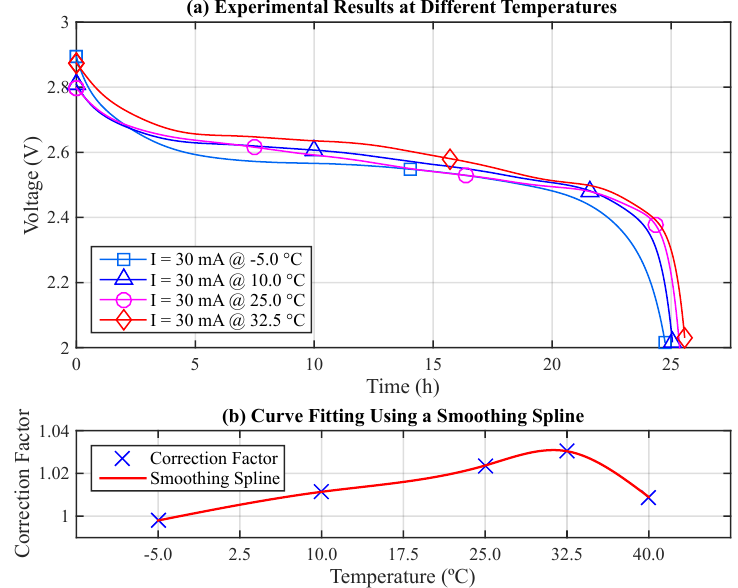
Figure 7. The battery-specific behavior. ( a ) Experimental results; ( b ) Curve fitting.